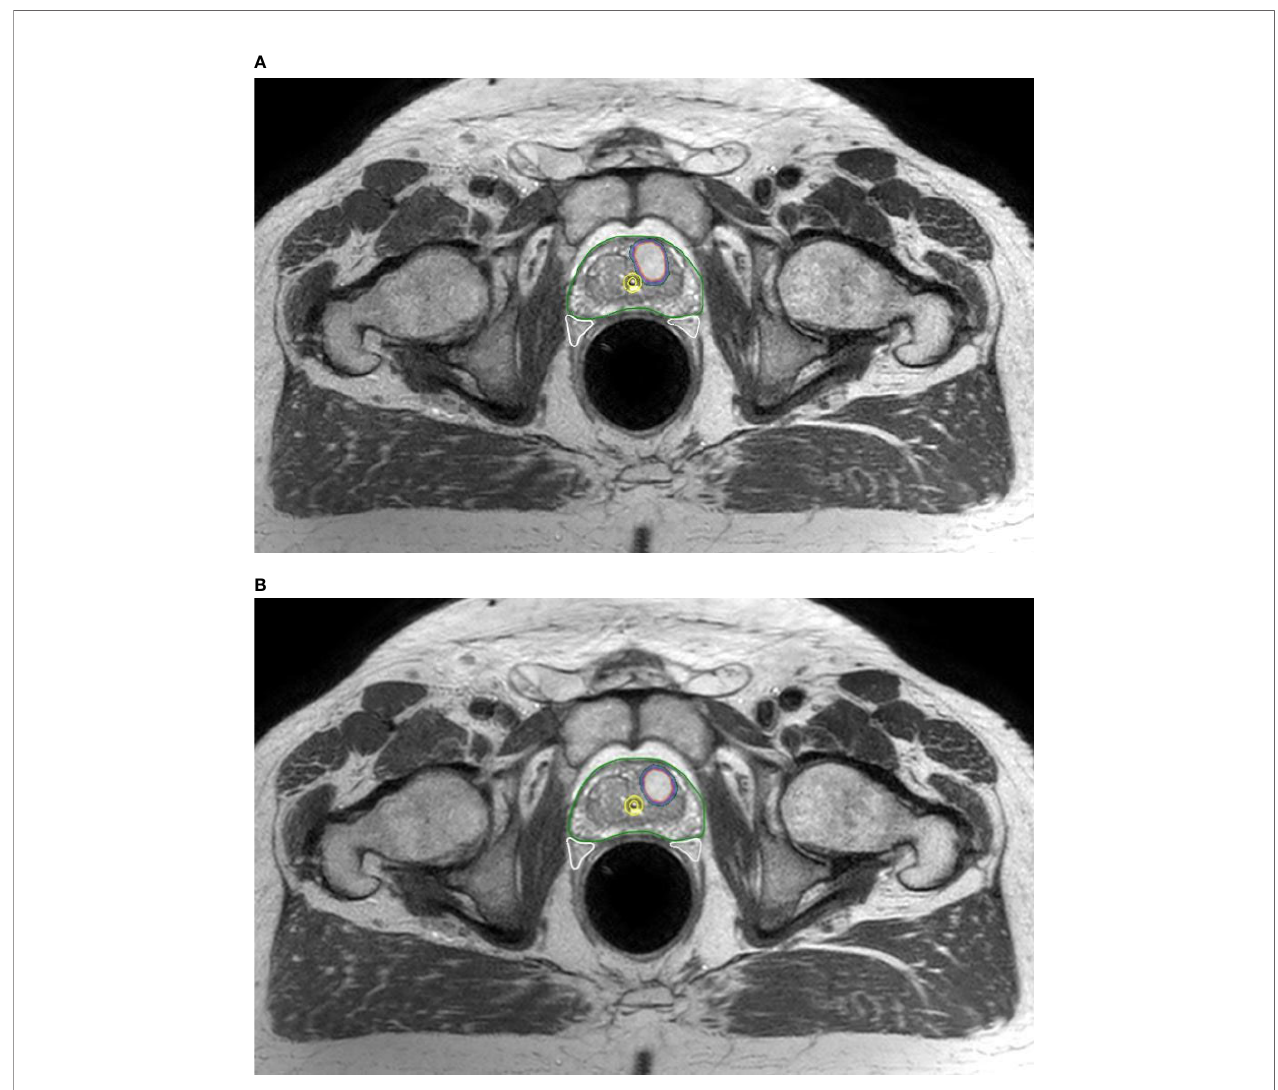
FIGURE 7 | 68 PSMA-detected relapse in a patient who received 5-fraction SABR. (A) Fused 68 PSMA-PET/CT and planning MRI show pretreatment location of 68 PSMA-detected dominant intraprostatic lesion (DIL) encompassed within the CTV and receiving the full 45 Gy prescription dose; (B) fused 68 PSMA-PET/CT acquired at the occurrence of biochemical relapse with the planning MRI scan shows persistence/recurrence of the DIL at the initial site.